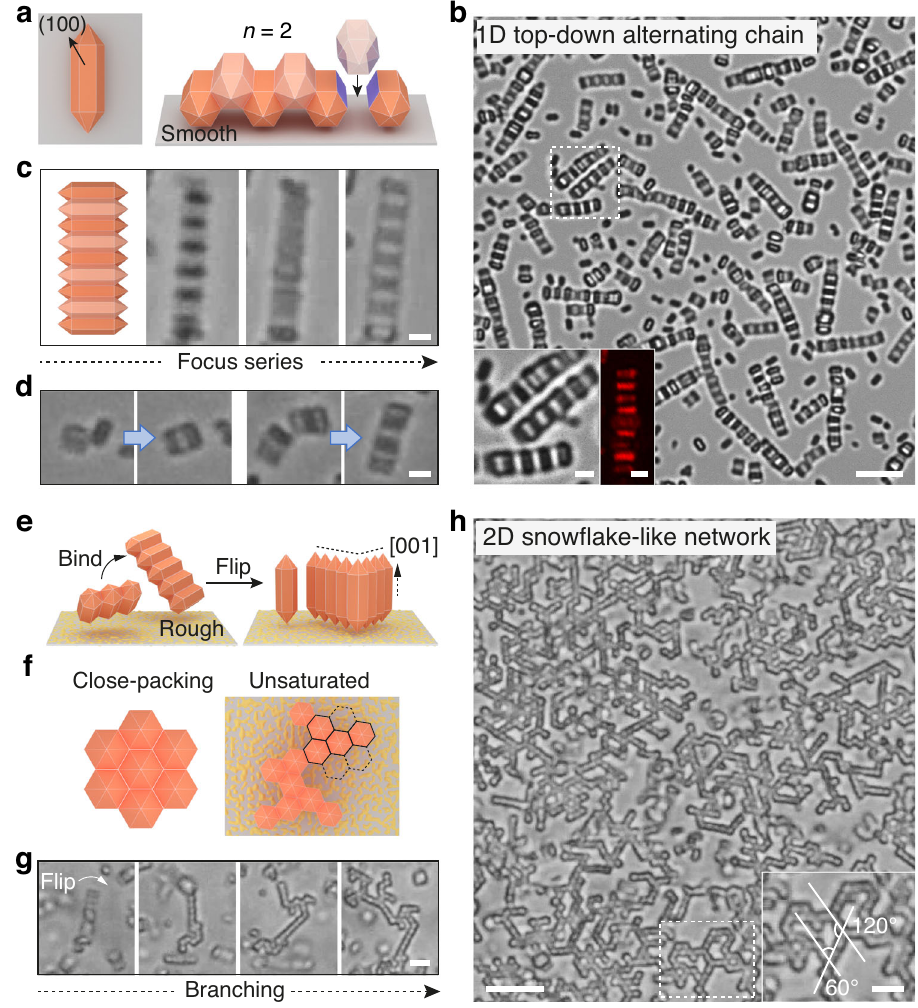
Fig. 3 Self-assembly of MIL-88A particles. a – d 1D top-down alternating chain of MIL-88A particles formed on a smooth substrate. a Cartoon (left) shows the particle orients its (100) face towards the substrate by depletion attraction. Cartoon (right) shows the particles in the upper layer (light brick red) bind with those at the bottom (dark brick red) by the side faces (purple, n = 2). b Optical image of MIL-88A chains. Inset is the zoomed-in optical and re fl ected- light confocal image of the chains, both showing an alternating pattern. Optical images and cartoon in ( c ) show a microscope focus series of the chain. Snapshots from a movie ( d ) show the chain formation process. e – h 2D snow fl ake-like network of MIL-88A particles, formed on a rough substrate (gray plate with yellow dots). Schematic in ( e ) shows two short chains bind via (100) faces to form a branch, which fl ips over and stands on the substrate by their pyramidal tips ([001] direction). Cartoons in ( f ) compare the fully coordinated structure ( n = 6, left) with the actual unsaturated network structure ( n ≤ 6, right). Optical images in ( g ) show the fl ipping and branching process. Optical image in ( h ) shows the snow fl ake-like networks and the angles of branch junctions (inset). Scale bars: 5 and 1 μ m (inset) for ( b ), 1 μ m for ( c , d ), 2 μ m for ( g ), 5 and 2 μ m (inset) for ( h